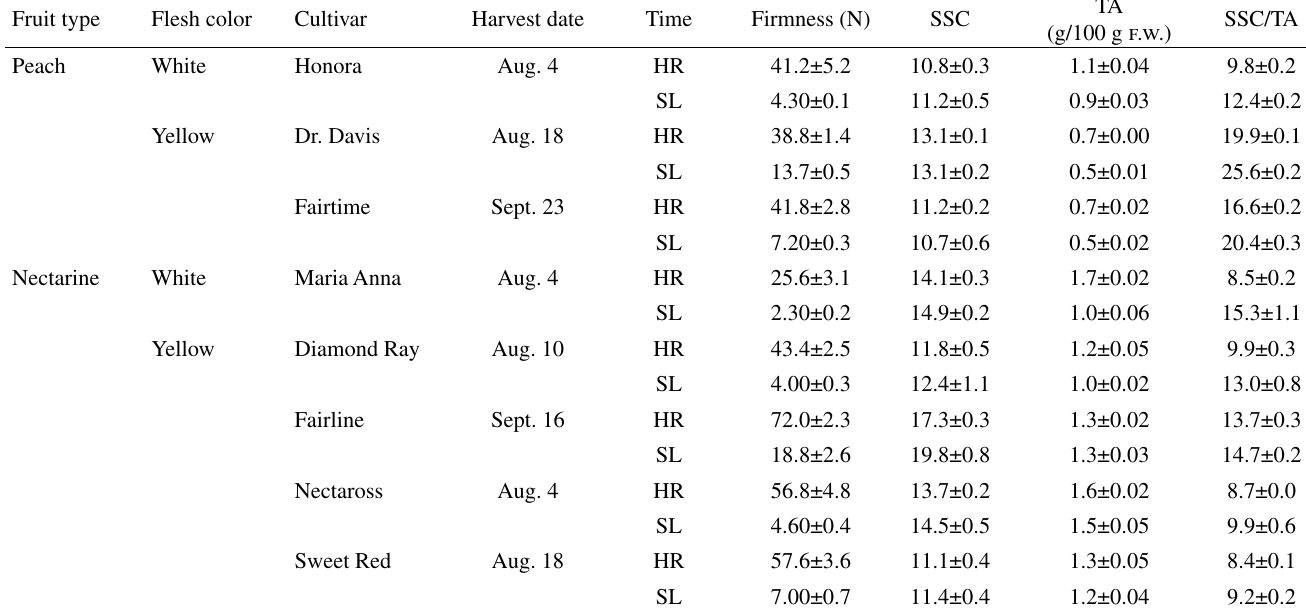
Table 1 - Physical and chemical characteristics (means ±standard error) of different peach and nectarine cultivars at harvest (HR) or after five days of shelf-life (SL) at 20°C